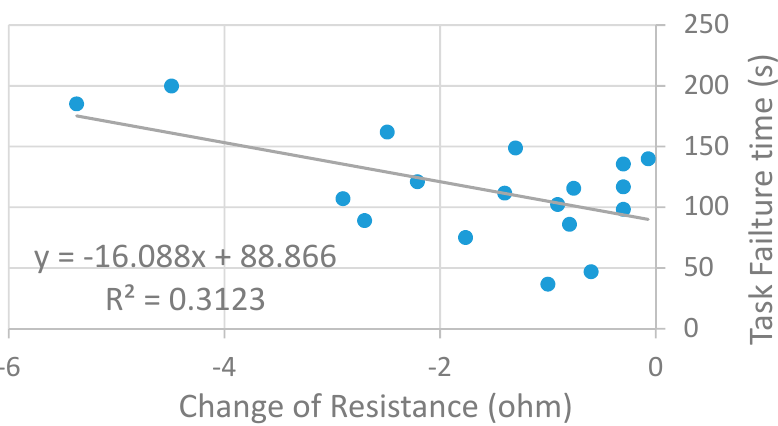
Figure 3. Resistance ( A ) and Reactance ( B ) at fatigue tests with two different frequencies (50 kHz and 100 kHz) (mean ± standard deviation, * indicates p < 0.05 between contraction conditions during fatigue task).